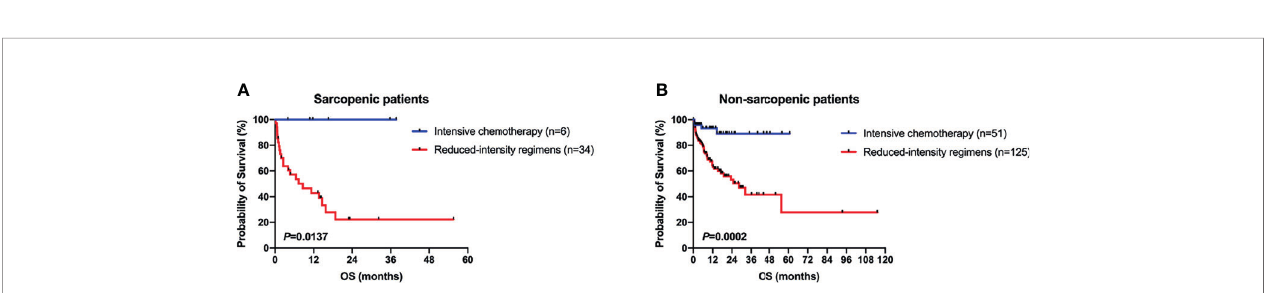
FIGURE 4 | Survival curves of patients strati fi ed by type of chemotherapy. (A) In sarcopenic patients, those who received intensive chemotherapy showed a signi fi cantly superior OS than reduced-intensity regimens ( P = 0.0137). (B) In non-sarcopenic ones, patients with intensive chemotherapy showed a signi fi cantly superior OS than reduced-intensity regimens ( P = 0.0002).